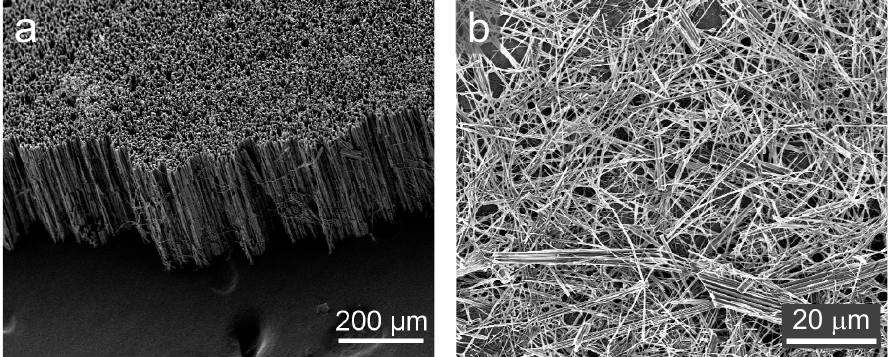
Figure 2. ( a ) Silicon wafer after the completion of the MACE, ( b ) Silicon nanowires deposited from IPA dispersion.